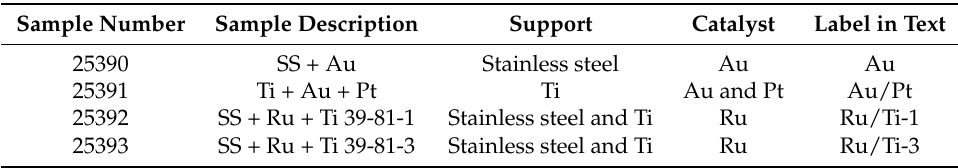
Table 1. Overview of the investigated samples. The sample description gives information about the support material (SS: stainless steel) and the catalyst